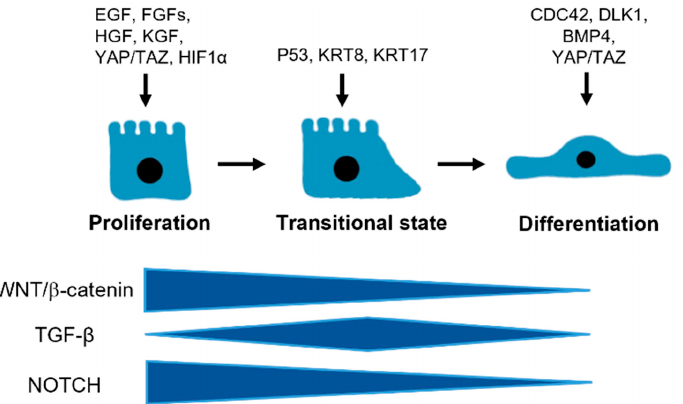
Figure 2. The regulation of ATII cell proliferation and differentiation. WNT/ β -catenin, TGF- β , and NOTCH pathways dynamically regulate ATII cell proliferation and differentiation into ATI cells, although there are still many unknowns during the transitional state. Other transcription factors, growth factors, and signaling molecules are also